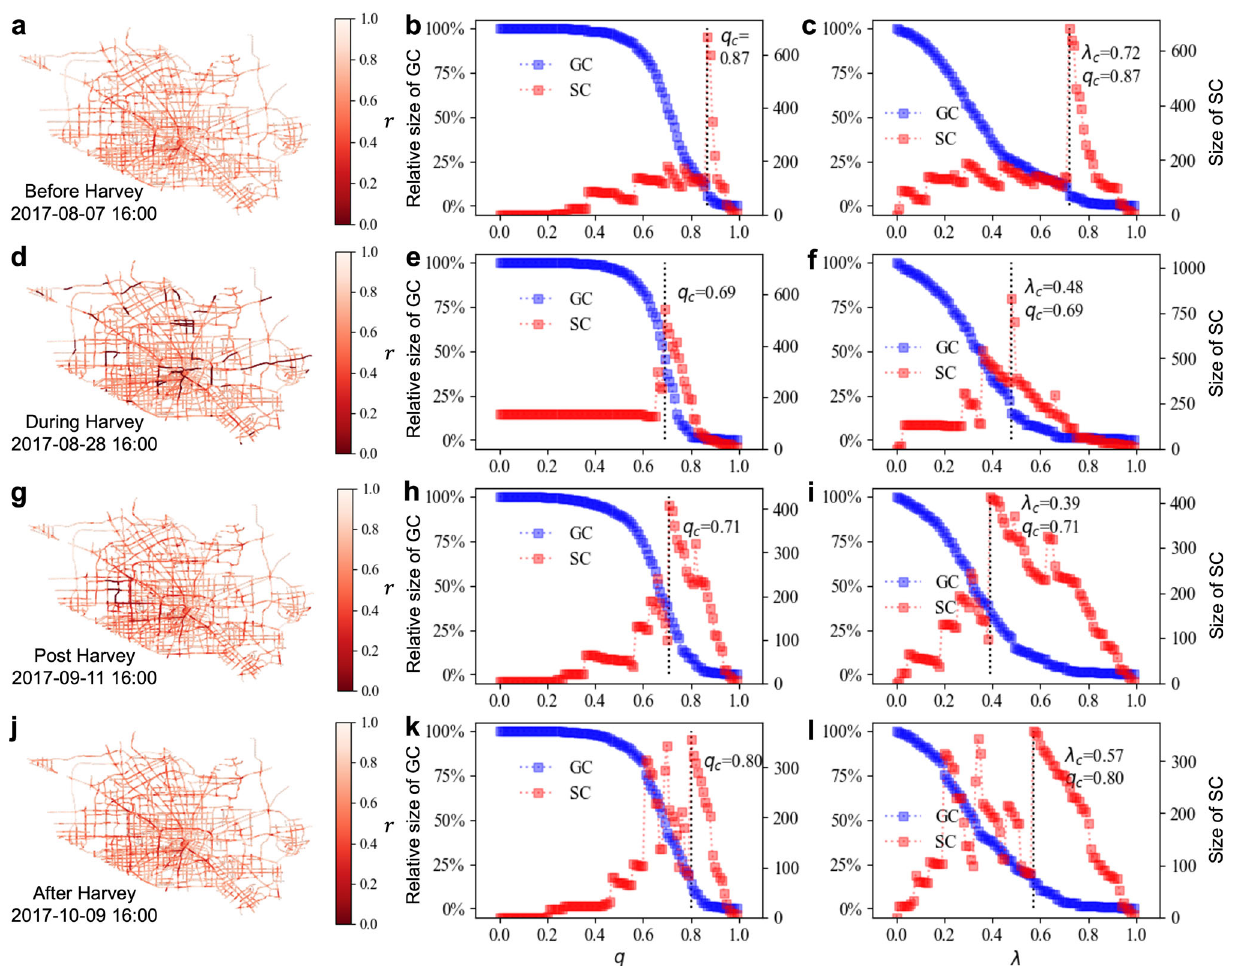
Fig. 3 Percolation analysis on Harris County ’ s transportation network under the in fl uence of fl ooding caused by Hurricane Harvey. a , d , g , j Transportation network service degradation snapshots before (August 1 – 24), during (August 25 – 31), post (September 1 – 21), and after Harvey (September 22 – October 31). b , e , h , k Percolation process as a function of link quality threshold q in different phases of Harvey. c , f , i , l Percolation process as a function of low link quality percentage λ . The irregular increase of the second giant component (SC) size (red square) is used to identify the critical percolation threshold in the giant component (blue square) phase